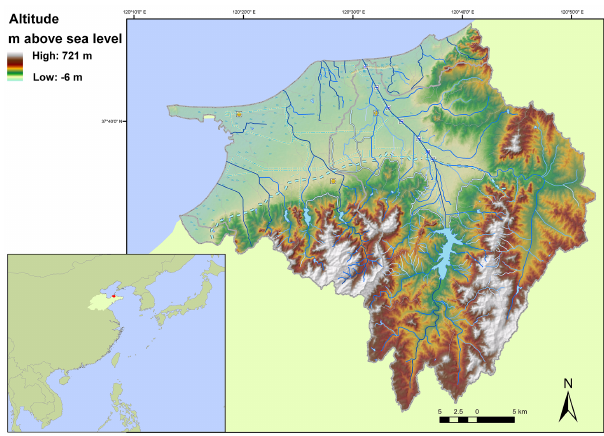
Figure 1. Location and altitude of the Huangshui river